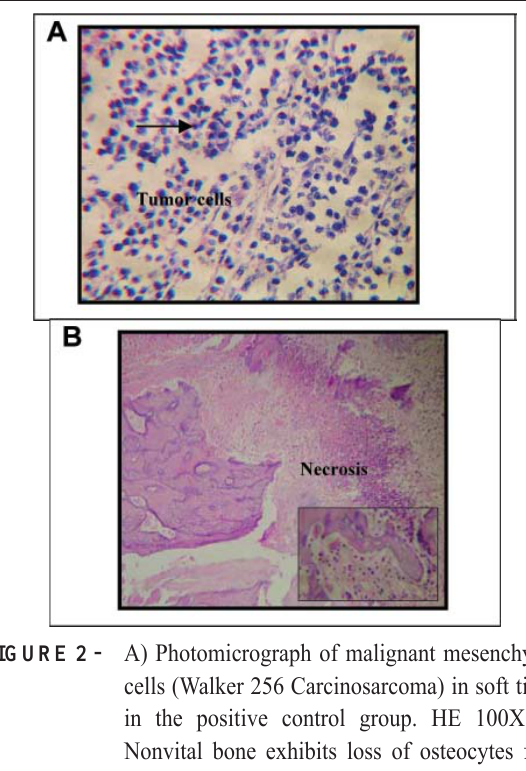
FIGURE 2 - A) Photomicrograph of malignant mesenchymal cells (Walker 256 Carcinosarcoma) in soft tissue in the positive control group. HE 100X.